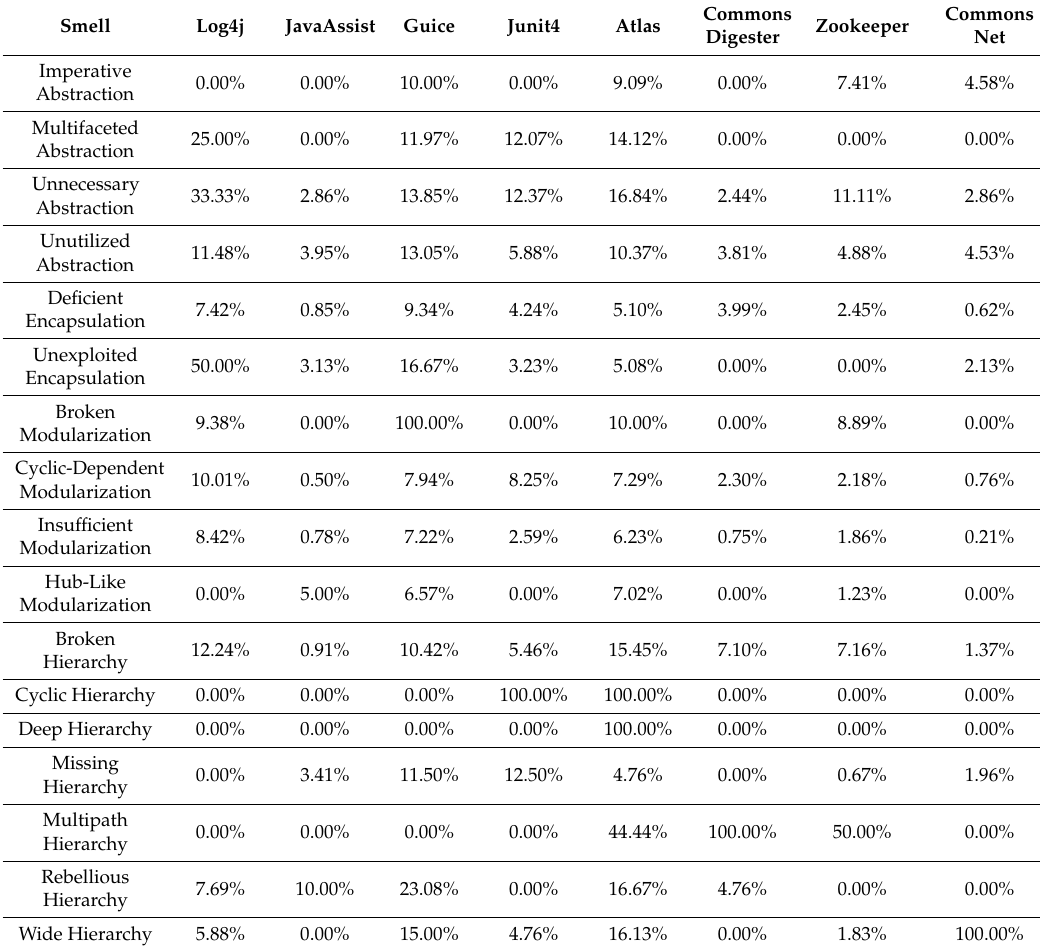
Table 6. Smells removed and distributed for